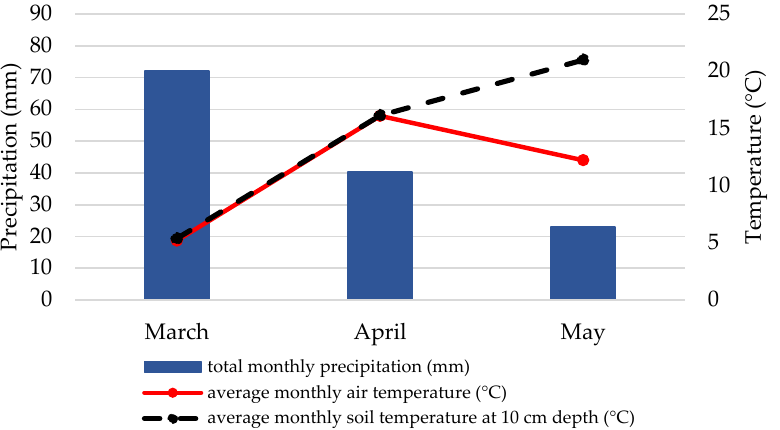
Figure 1. Weather conditions (the average monthly air temperature, total monthly precipitation and average monthly soil temperature at 10 cm depth) in March, April and May 2018, Zagreb. Data are presented up to 10 May 2018.